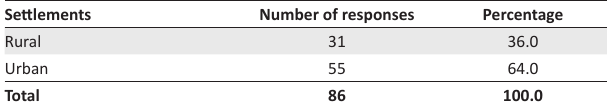
TABLE 1: Participation based on rural and urban settlements.